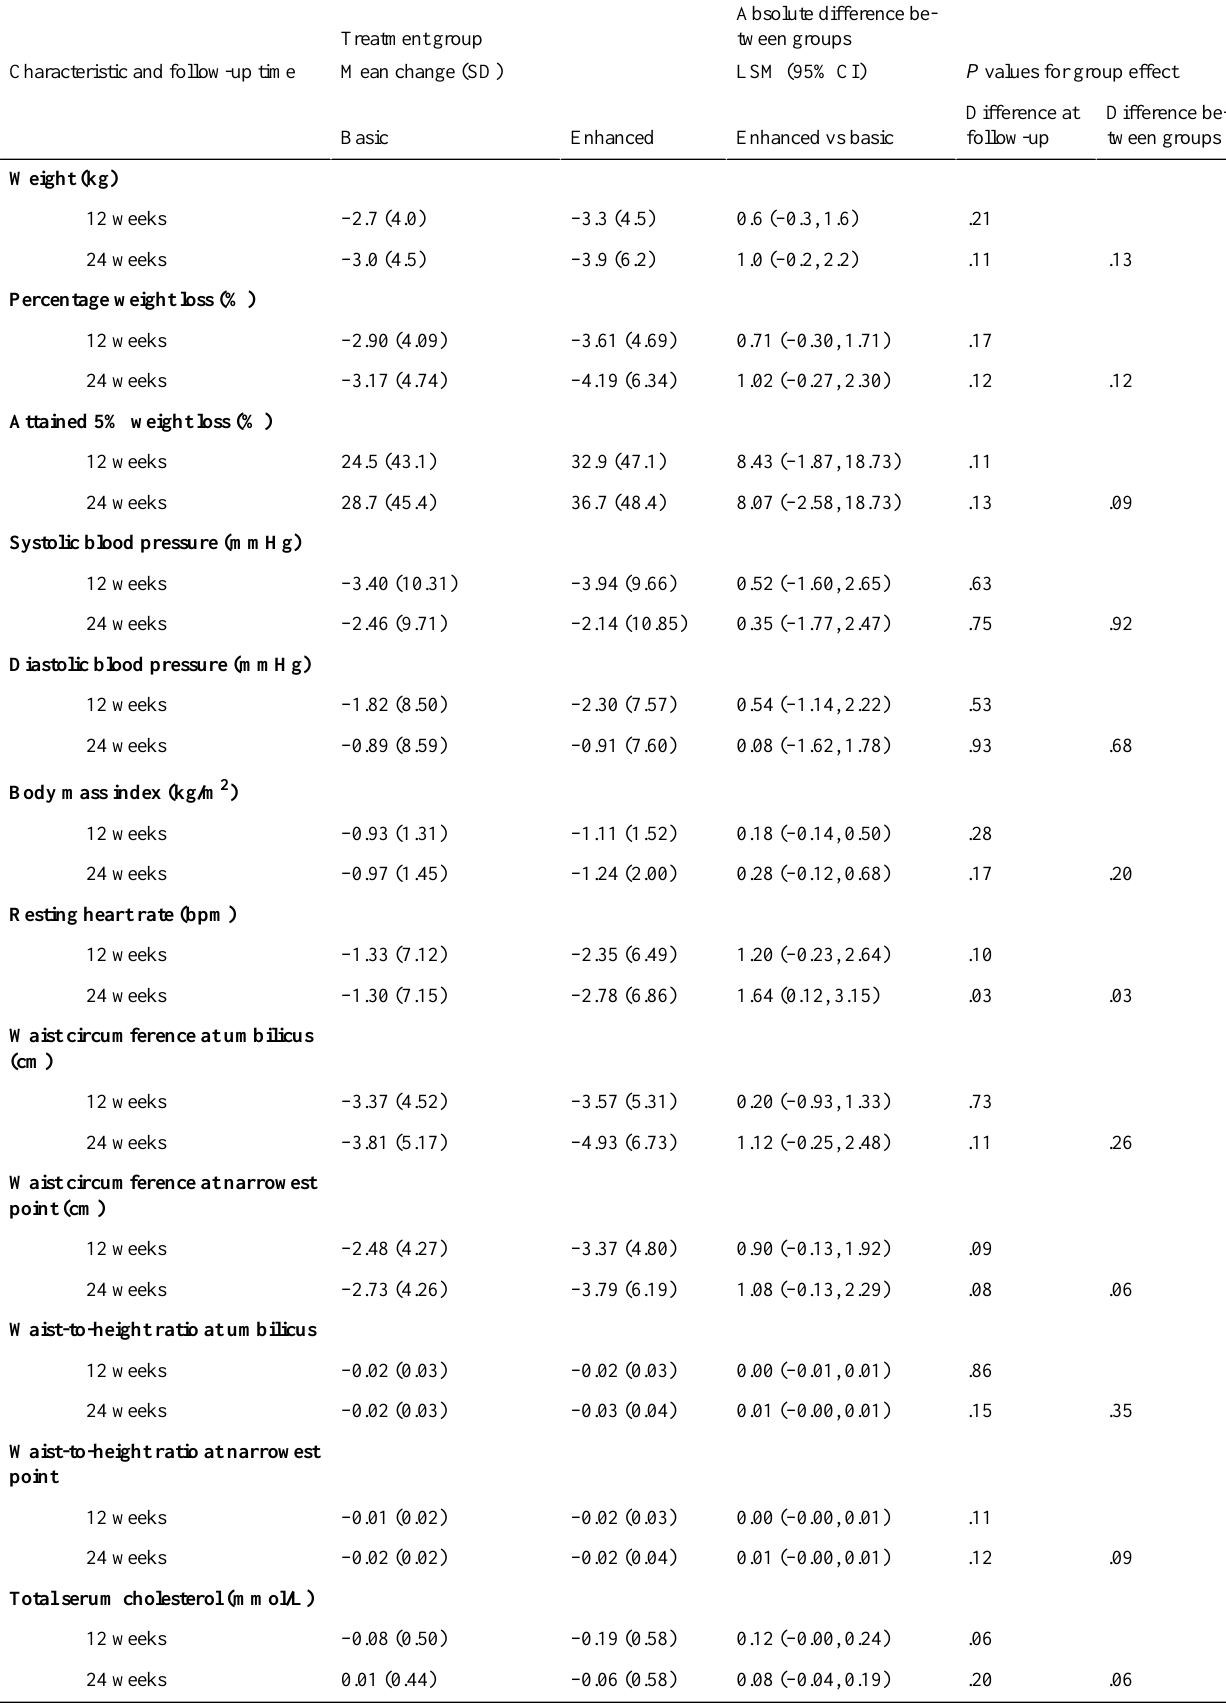
Table 4. Mean change in a range of variables from baseline to 12 weeks and baseline to 24 weeks within each treatment group and the least squares mean (LSM) difference in change between treatment groups (ITT population BOCF